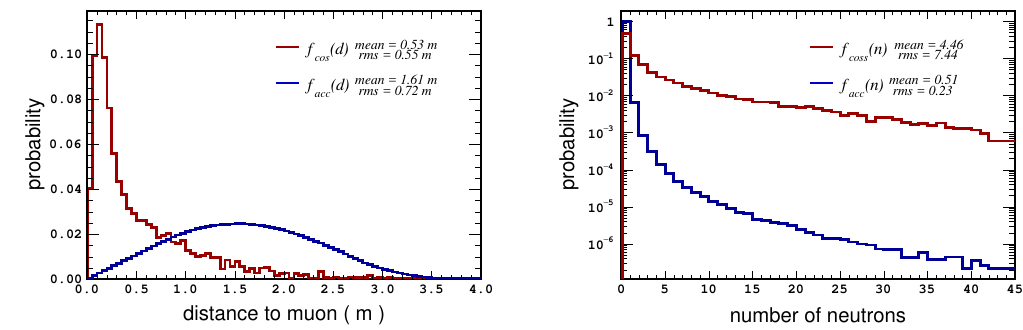
Figure 4 . The probability density functions for cosmogenic candidate selection f cos (red) and f acc (blue), used in equation (4.1). Distance between prompt and muon f ( d ) is shown on the left and number of neutrons after muon f ( n ) on the